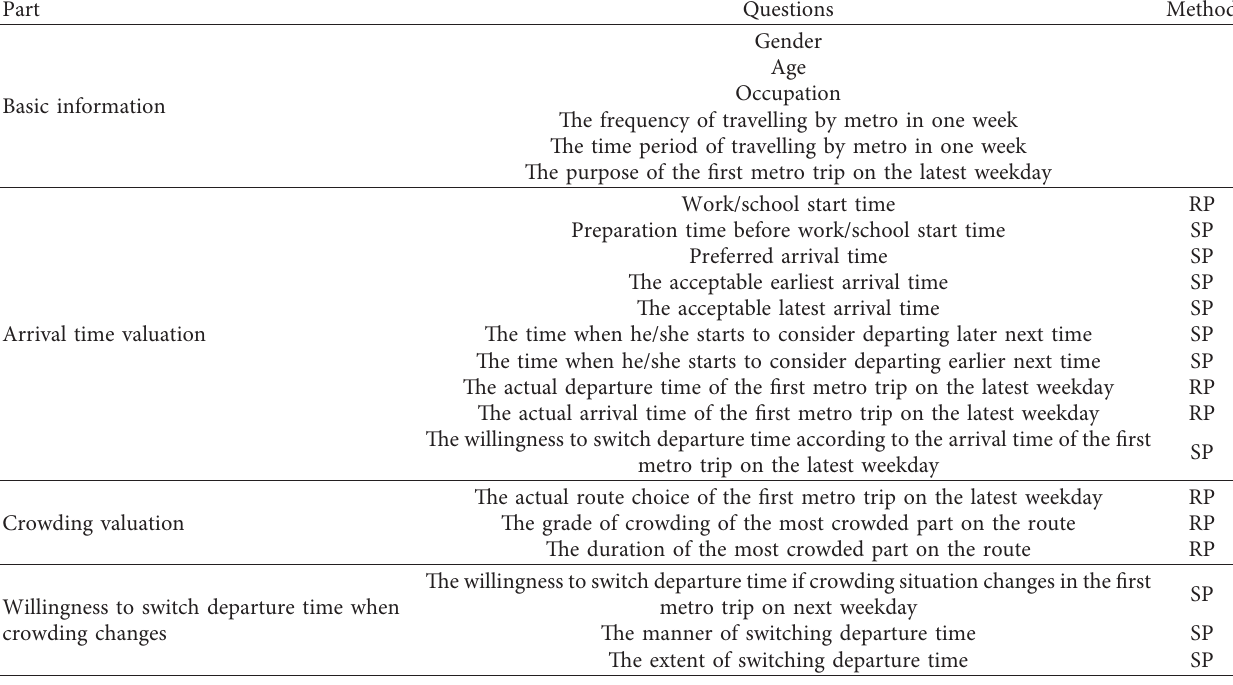
Table 3: The combined RP and SP